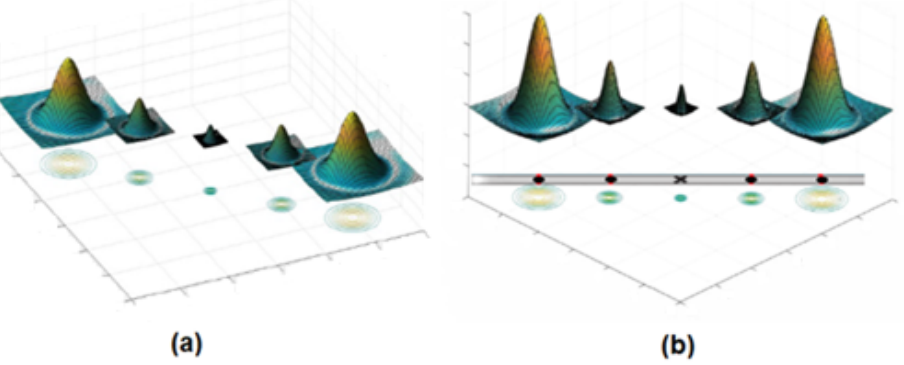
Figure 4. ( a ) DoG responses display the contours of each response; and ( b ) the representation of the blood vessel as a straight line and recognizing the five points to design the SRF filters.